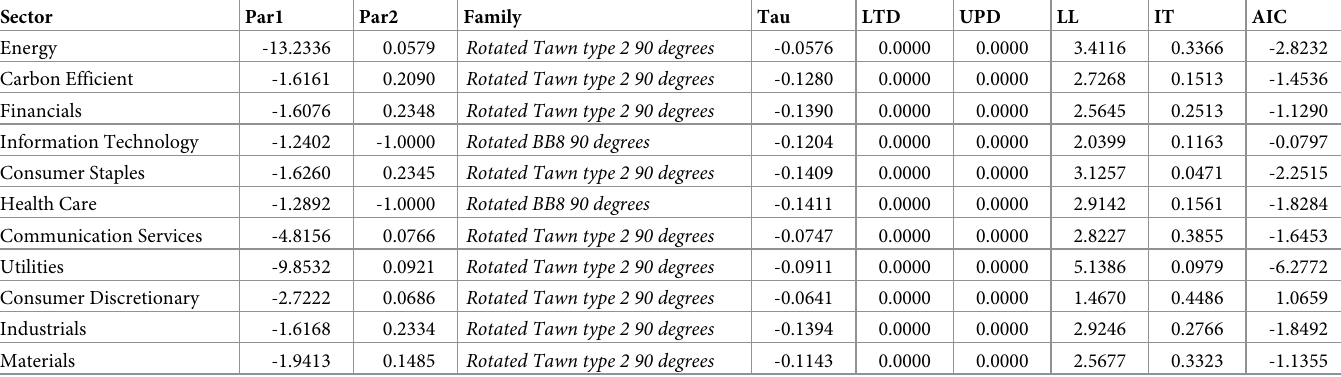
Table 7. Copula results during the COVID-19